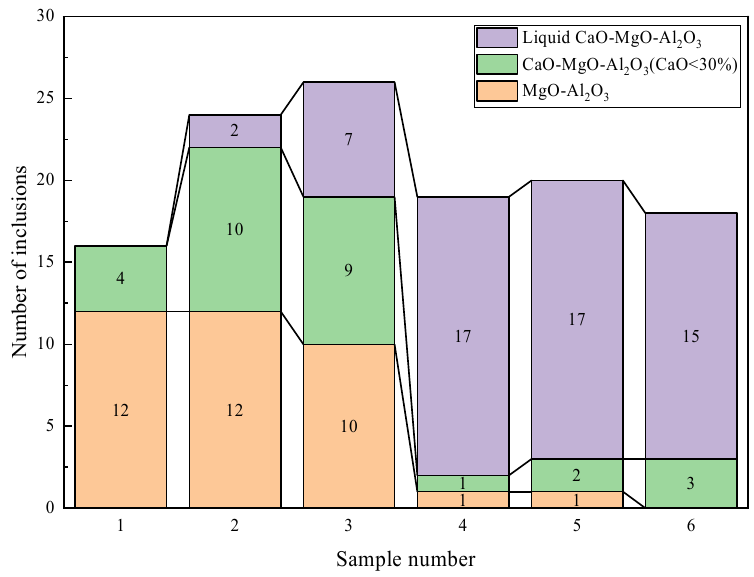
Figure 5. Number of inclusions of different types in all samples.